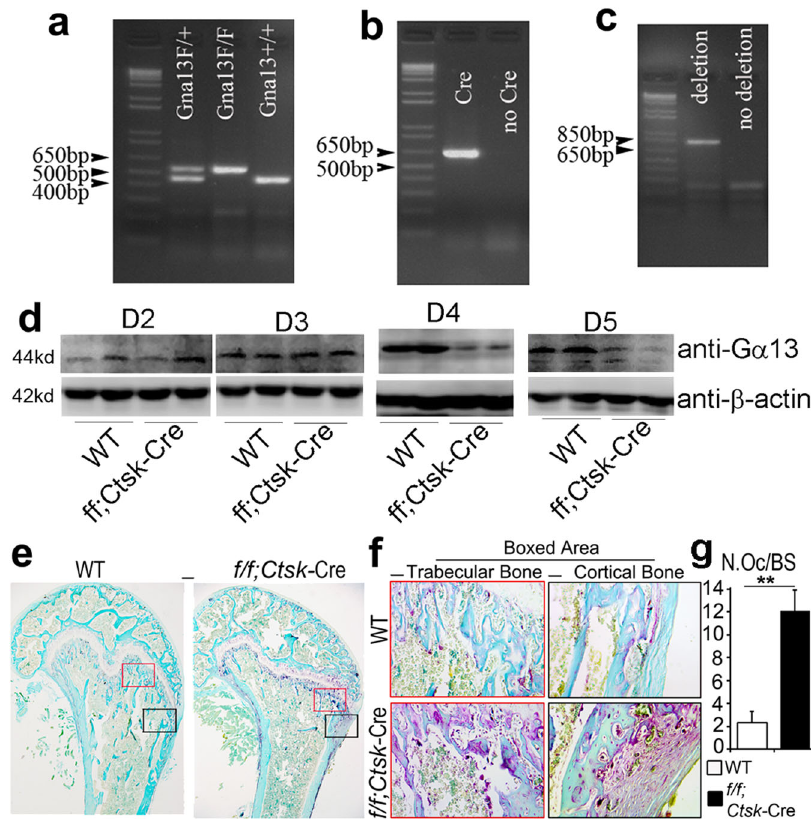
Fig. 3 Bone density was decreased in osteoclast-lineage cell speci fi c Gna13 de fi cient mice